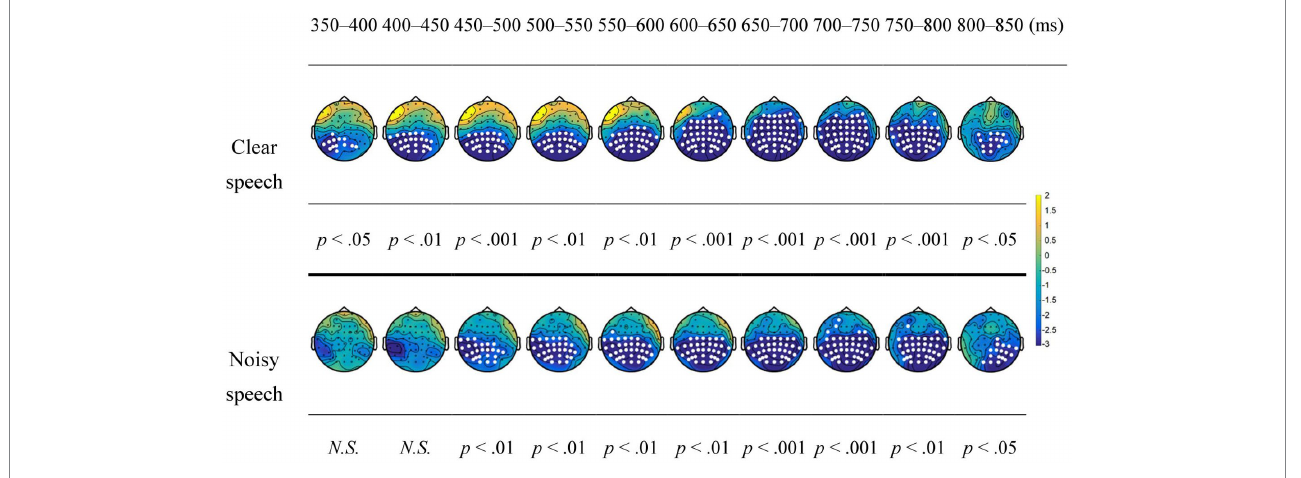
FIGURE 2 Topographic maps for the predictability effect on the N400 under the clear and noisy conditions in a moving time window analysis. White dots represent the electrodes that show significant differences in the contrasts. N.S., not significant.